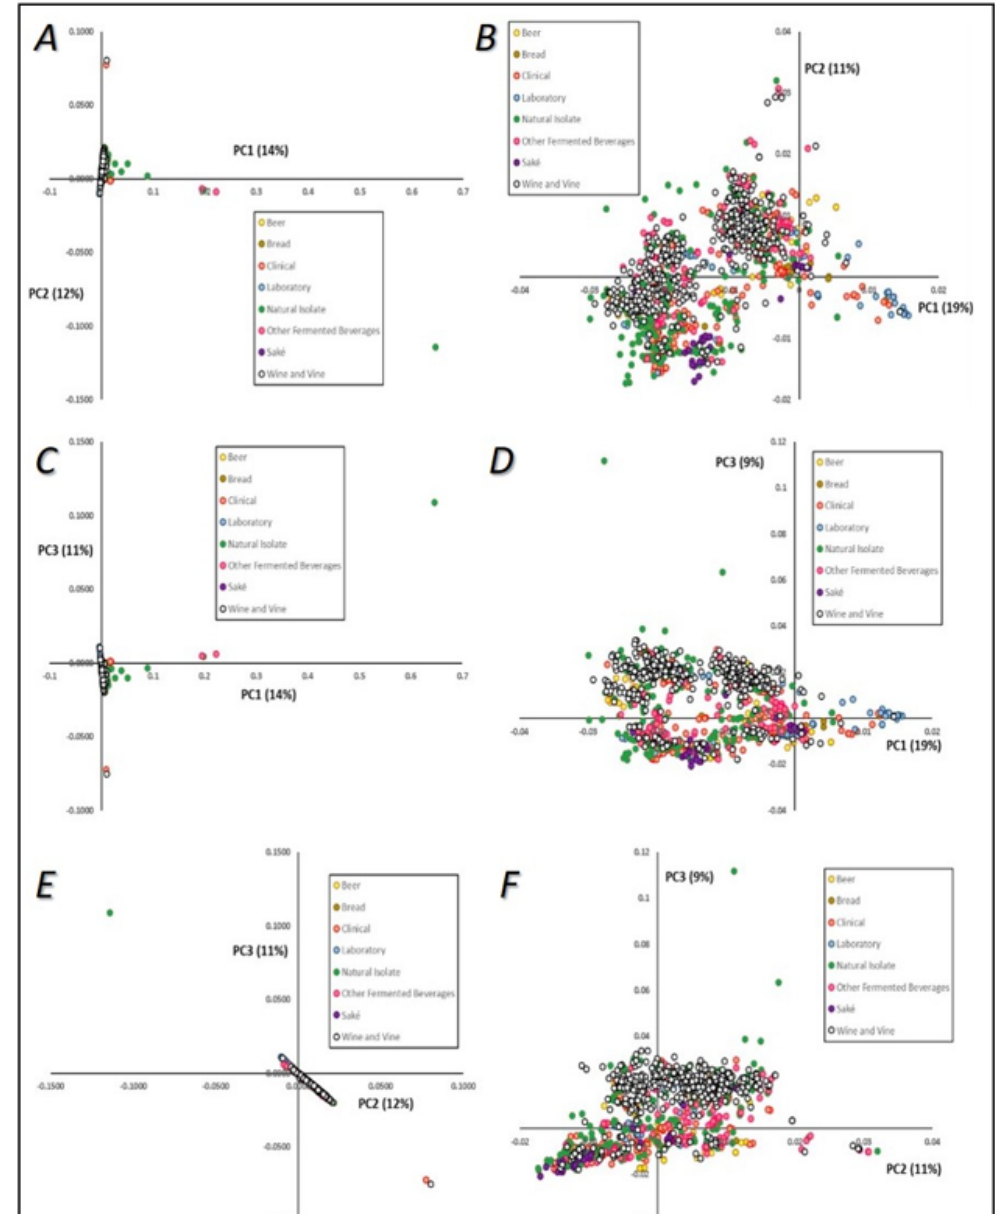
Figure 4. Principal component (PC) analysis visualization of the mtDNA genomes of Saccharomyces cerevisiae . Colors are indicative of strains’ technological applications. A —PC1 versus PC2; B —PC1 versus PC2, after exclusion of outliers defined in Panel A ; C —PC1 versus PC3; D —PC1 versus PC3, after exclusion of outliers defined in Panel C ; E —PC2 versus PC3; F —PC2 versus PC3, after exclusion of outliers defined in Panel E .